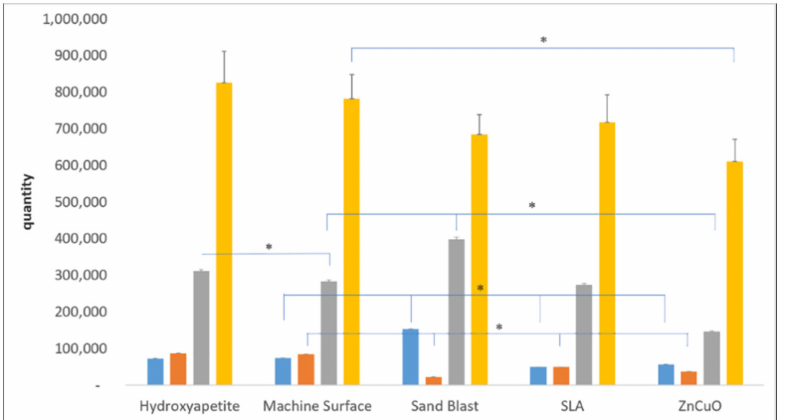
Figure 3. qPCR quantification of bacteria in multispecies biofilms grown on machined, sandblasted, SLA, and ZnCuO-coated titanium surfaces and hydroxyapatite discs after 14 days. Number of each bacterial species: P. gingivalis (blue columns), F. nucleatum (orange columns), S. sanguis (gray columns), and A. naeslundii (yellow columns), expressed as the mean + SD ( n = 9; asterisk indicates p < 0.05). The bacterial viability in the multispecies biofilms grown on the various disc surfaces after 14 days of incubation is shown in Figure 4. The sandblasted surface showed a higher live/dead bacteria ratio compared with that of the machined and the ZnCuO-coated surfaces.